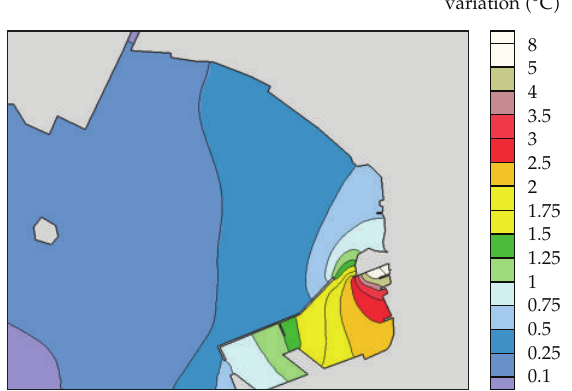
Figure 19: Spatial distribution of the mean increment water temperaturegenerated by the outflowof power plant.